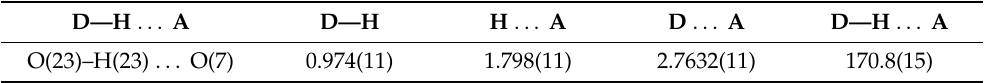
Table 1. Hydrogen bonding parameters for 4 (Å, ◦